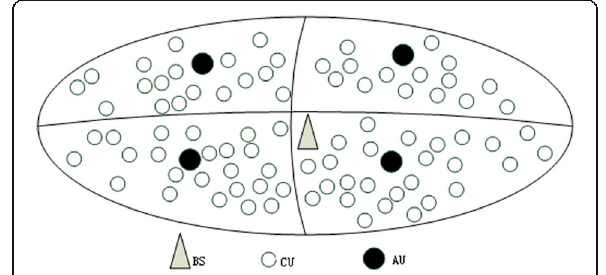
Fig. 3 Space and spectrum similarity CWSN model